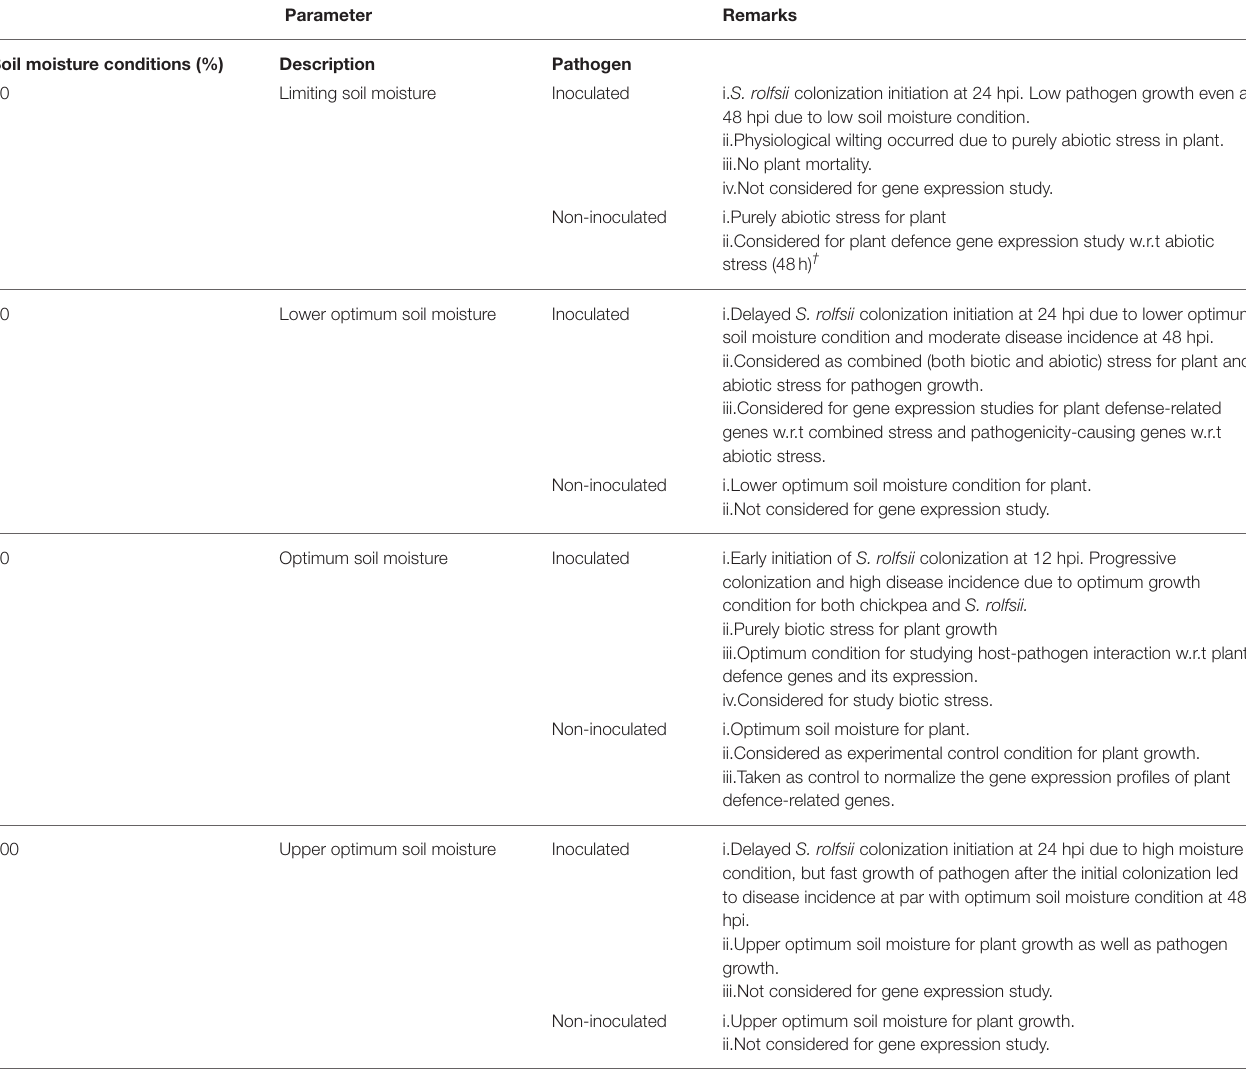
TABLE 1 | Details of experimental set up used to study Sclerotium rolfsii and chickpea interaction and summary of the